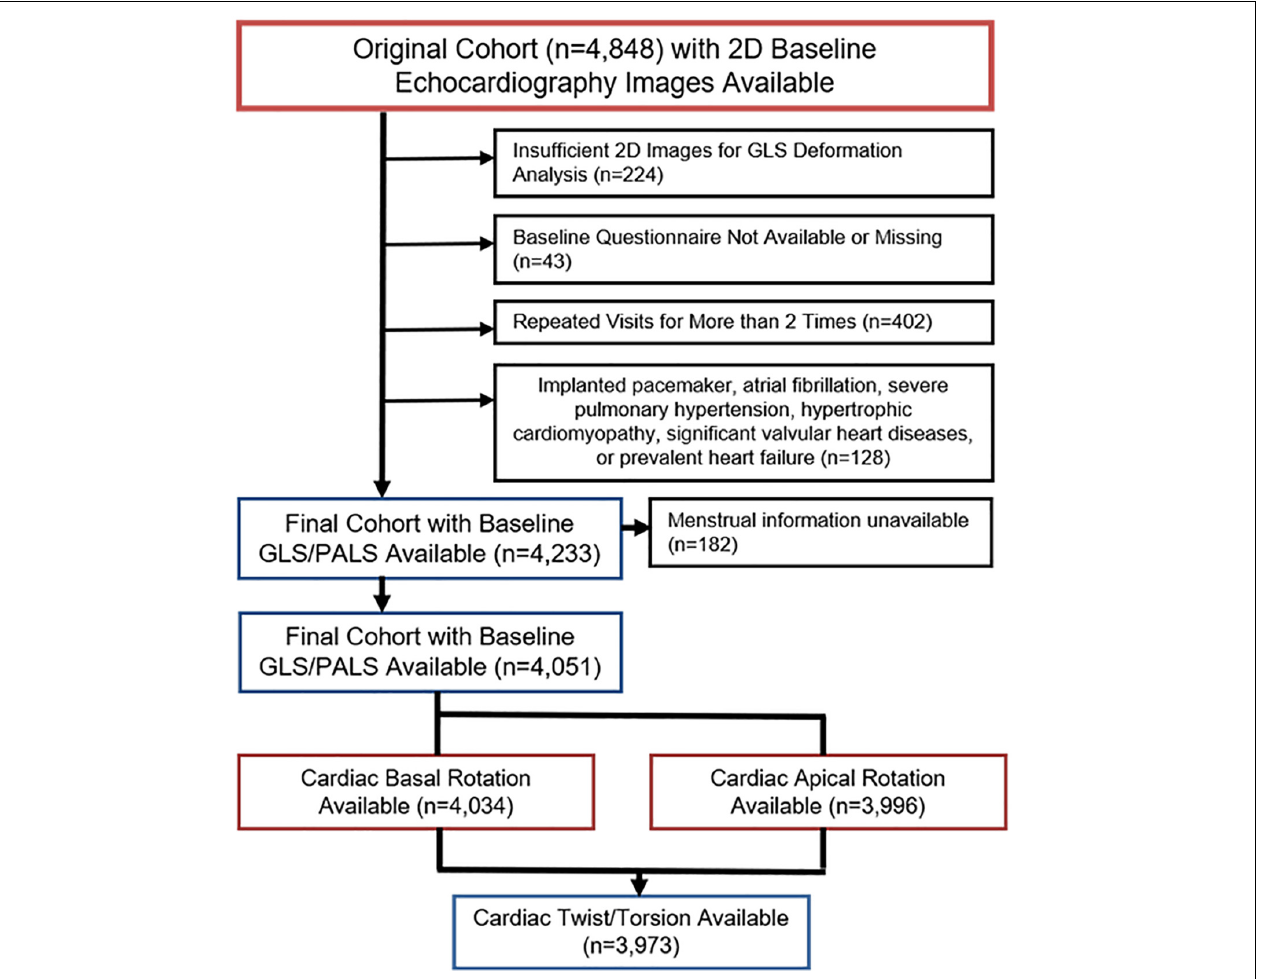
FIGURE 1 | Schematic flow diagram after exclusion and final selection of study population.